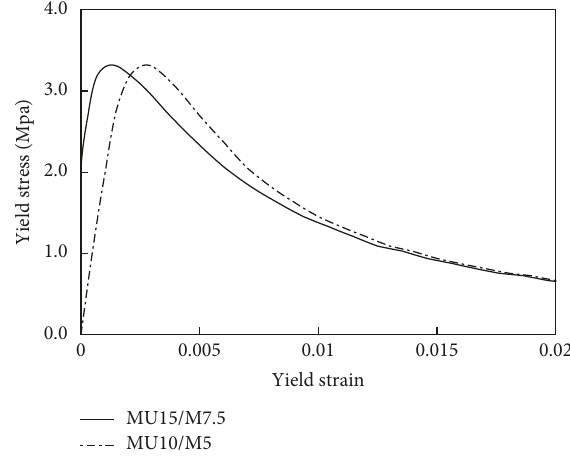
Figure 3: Constitutive relationship curve of masonry compression plasticity damage.